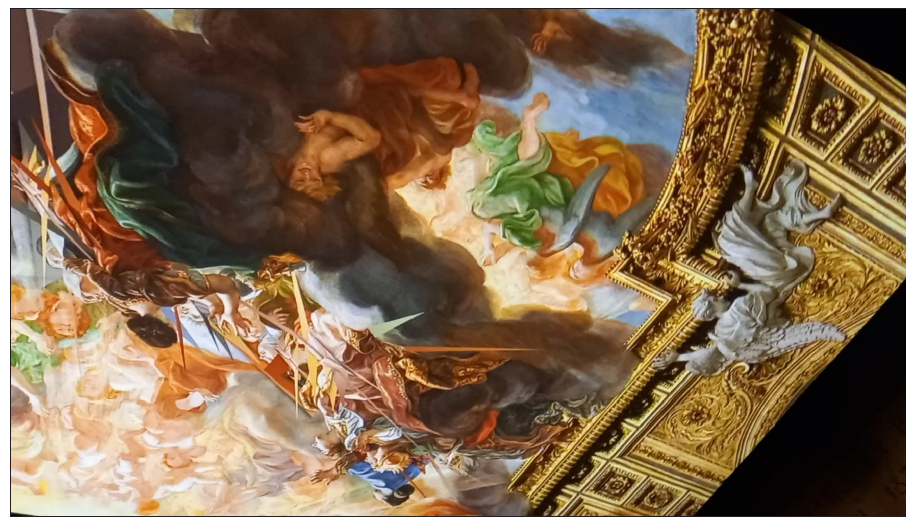
Figure 1: Davide Quayola. Strata #1, 2008. Photo Susan Broadhurst, 29 th September,